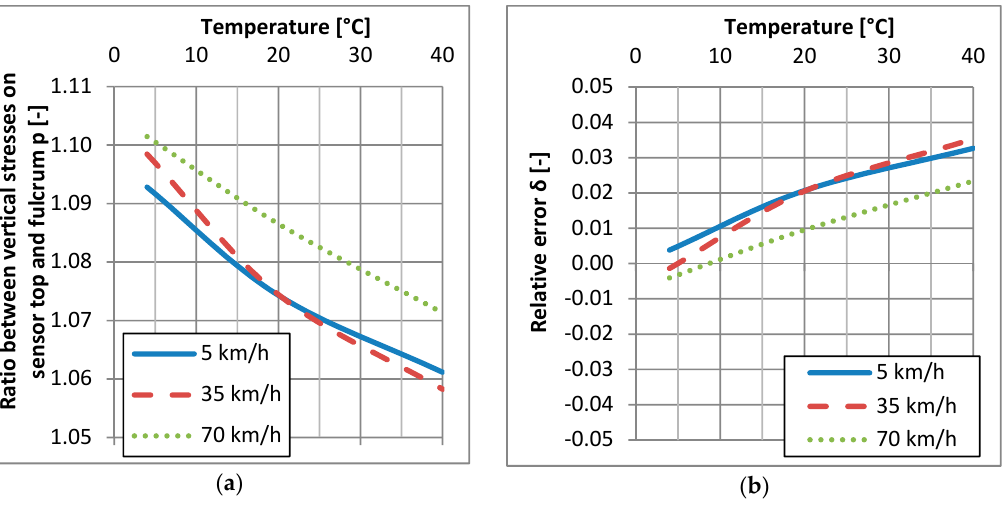
Figure 10. Example of theoretical analysis of relative error occurrence on the WIM station with quartz sensors ( a ) ratio p between the vertical stresses σ zz on the surface level and on the level of the sensor fulcrum ( b ) relative error δ caused by the change of pavement temperature and vehicle speed in relation to conditions during calibration of the WIM station (T = 20 °C and v = 70 km/h).